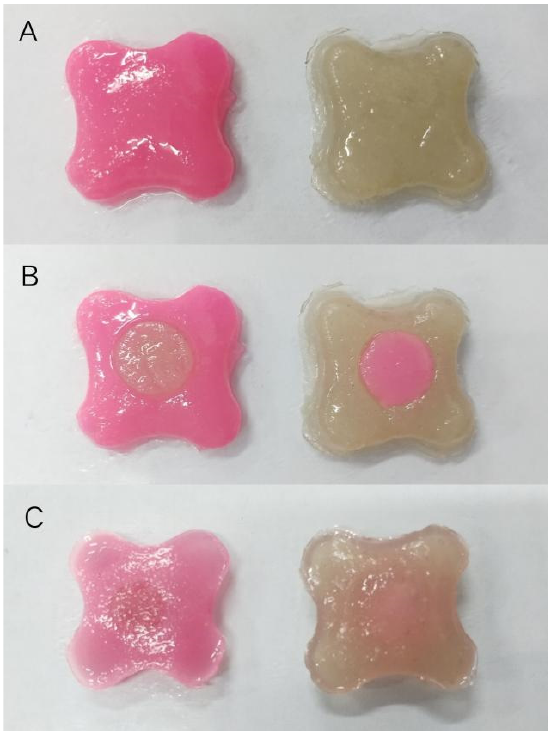
Figure 6. Self-healing properties of hydrogels: ( A ) the prepared hydrogel gel; ( B ) disc placed back into hole for self-repairing at room temperature; ( C ) fully repaired gel.